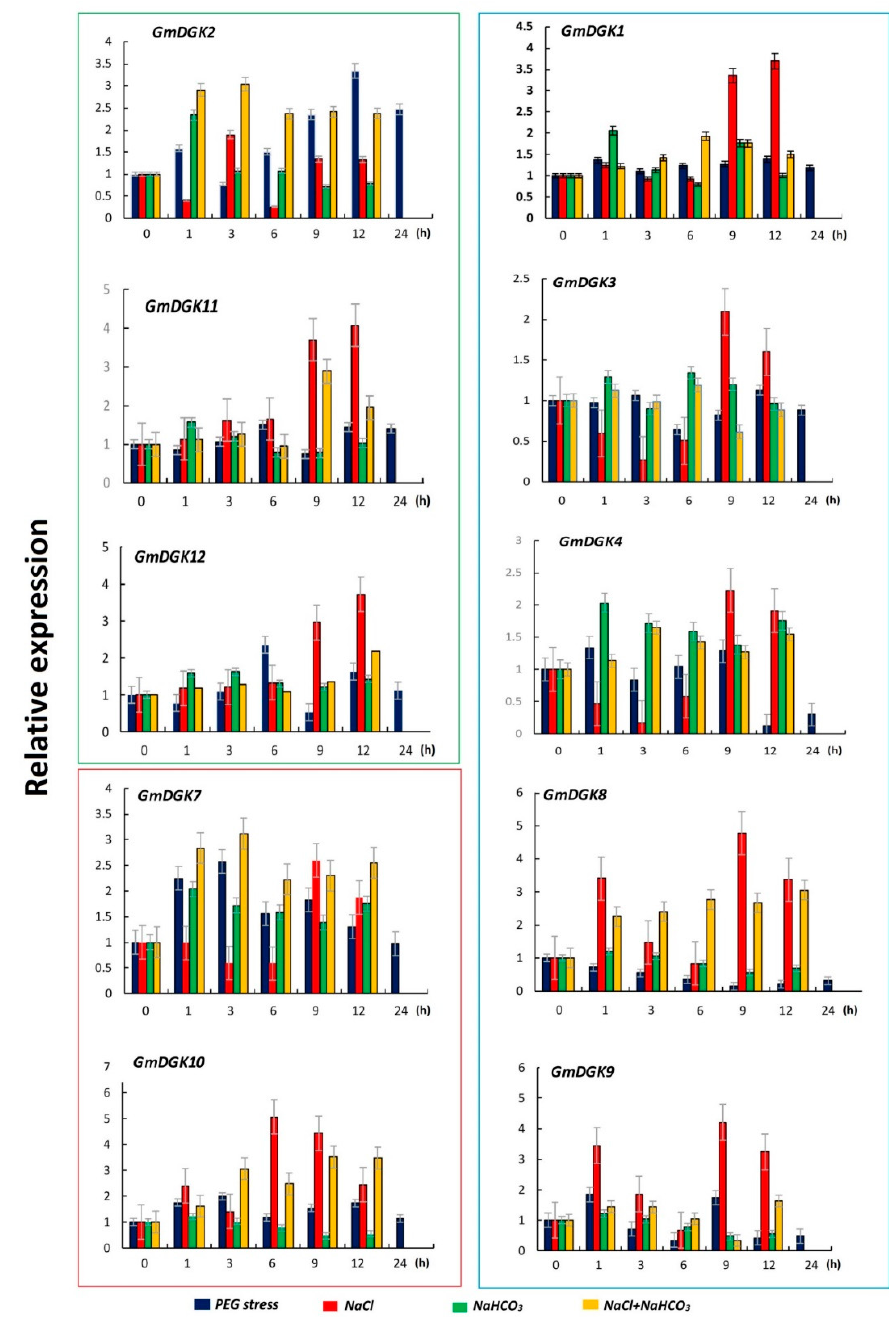
Figure 8. Soybean expression levels of DGK genes in root tissues under abiotic stresses with EF1A as a reference gene; the detection of their expression levels under various stress applications at different time points is shown.